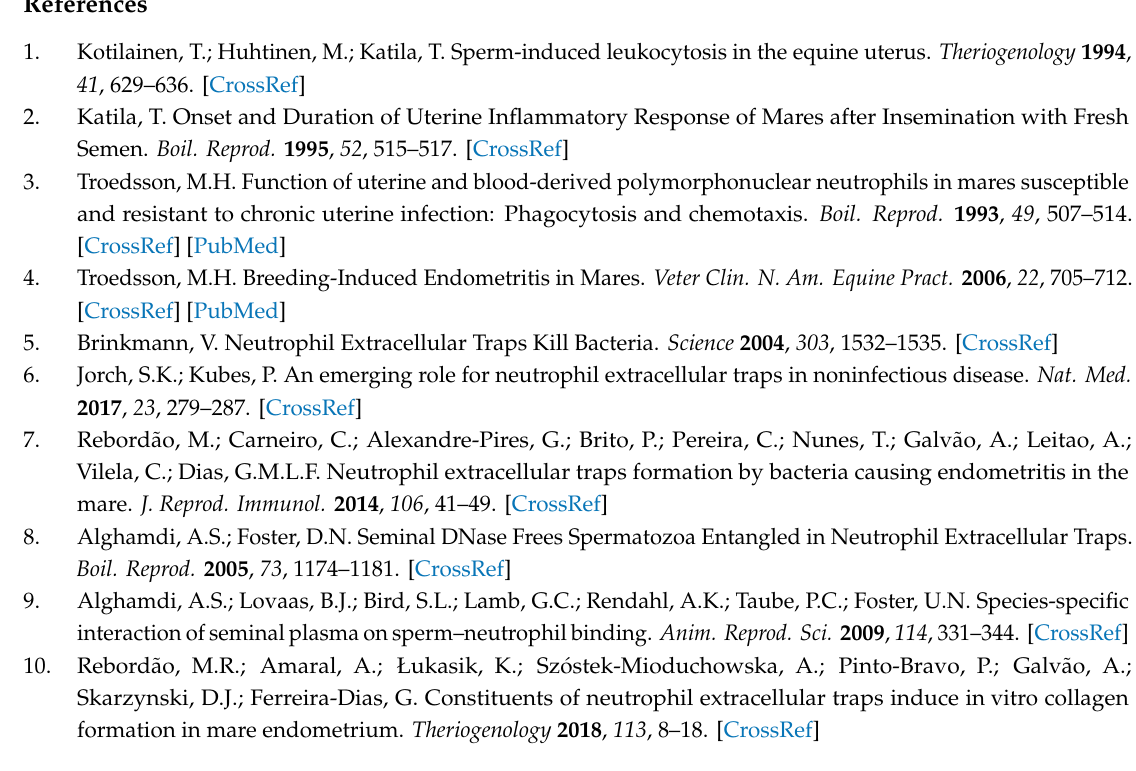
Figure S1: Representative panels of type I collagen western blotting and MMP-2 and MMP-9 zymograms, Table S1: Levels of significance for 2- and 3-way interactions between estrous cycle phases, treatment time, and elastase or sivelestat treatments in the evaluated variables, Table S2: Listed significant di ff erences of the same treatments between the follicular phase and mid-luteal phase of the estrous cycle, within each treatment